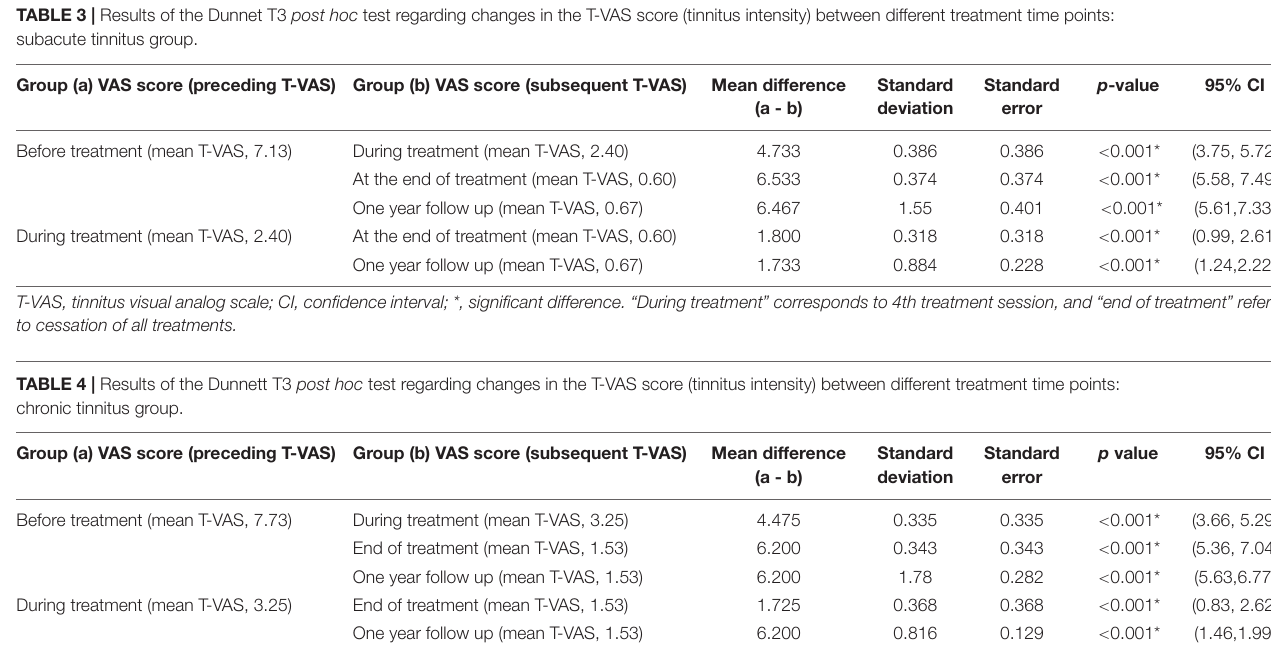
TABLE 3 | Results of the Dunnet T3 post hoc test regarding changes in the T-VAS score (tinnitus intensity) between different treatment time points: subacute tinnitus group. Group (a) VAS score (preceding T-VAS) Group (b) VAS score (subsequent T-VAS) Mean difference Before treatment (mean T-VAS, 7.13)